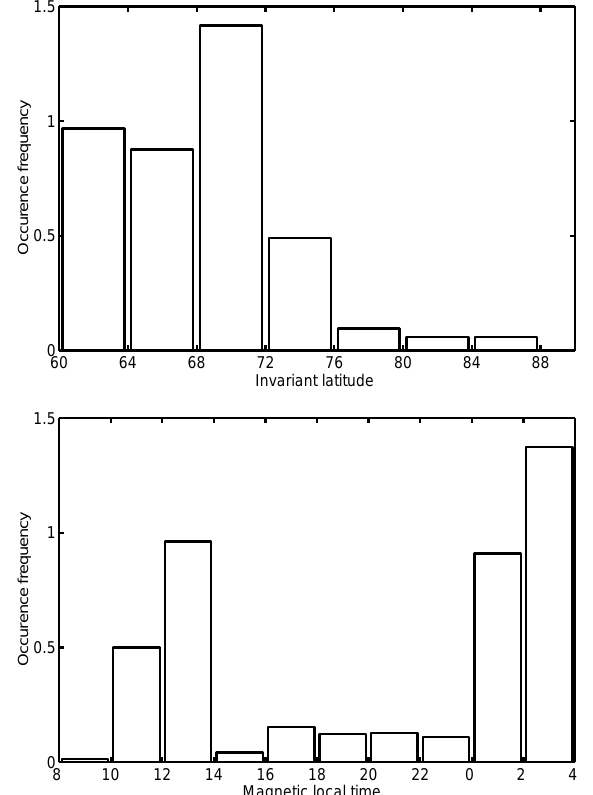
Fig. 6. The distribution of the identified Cluster lower hybrid cavi- ties in invariant latitude (upper panel) and MLT (lower panel). The normalisation is the number of cavities per 5min of observation time in the region of interest. Five minutes typically corresponds to about 1400km along the spacecraft path. Note that between 04:00 and 08:00 MLT, almost no data were taken, so this MLT interval is not included in the lower panel.